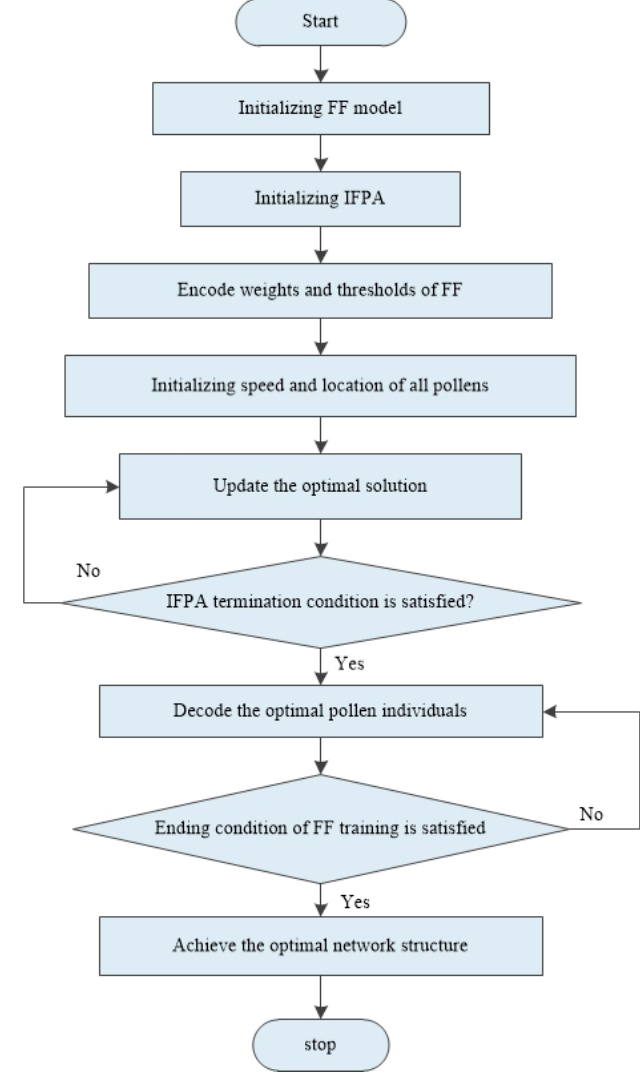
Figure 4. Flowchart of the improved flower pollination algorithm–feedforward (IFPA–FF) prediction model.